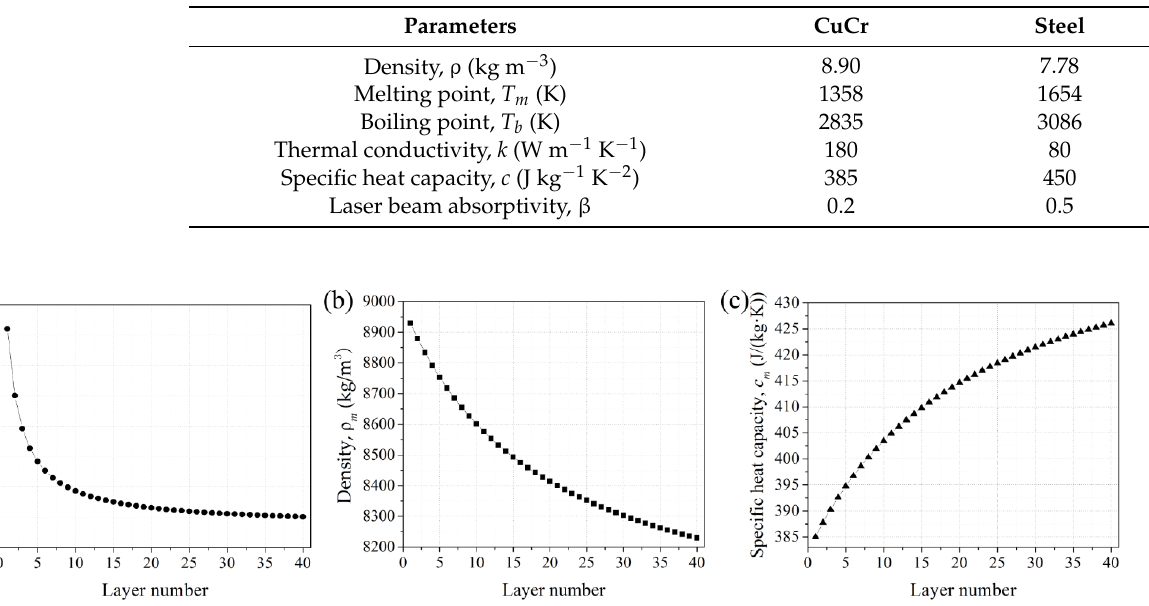
Figure 6. The calculated layer-dependent effective physical properties of the copper/steel bimetal: ( a ) effective thermal conductivity; ( b ) effective density; ( c ) effective specific heat capacity.